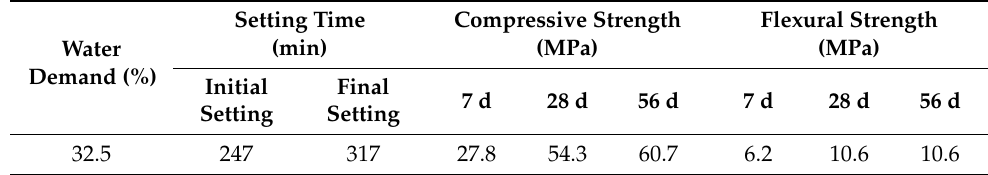
Table 1. Physical and mechanical properties of CEM III/B 42.5 L–LH/SR/NA.